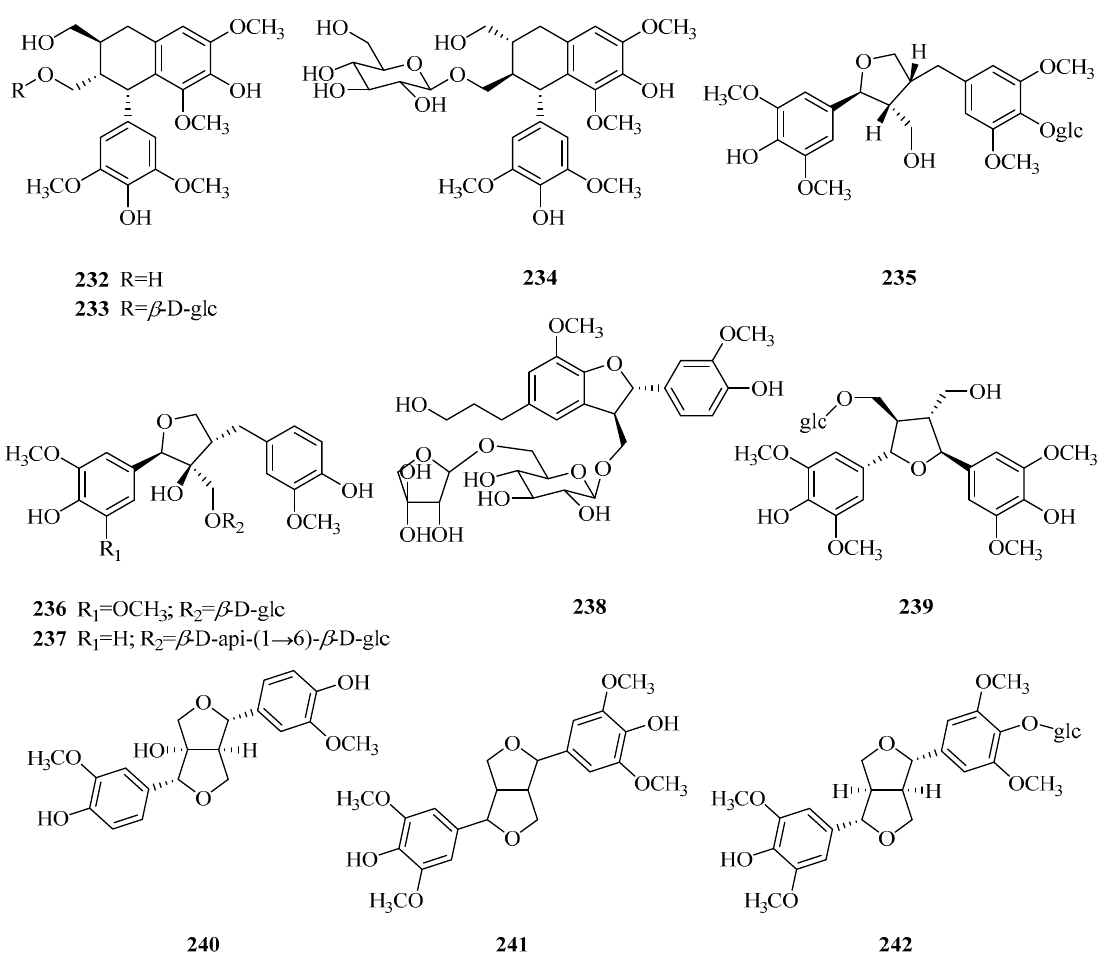
Figure 7. Phenylpropanoids from the genus Periploca.